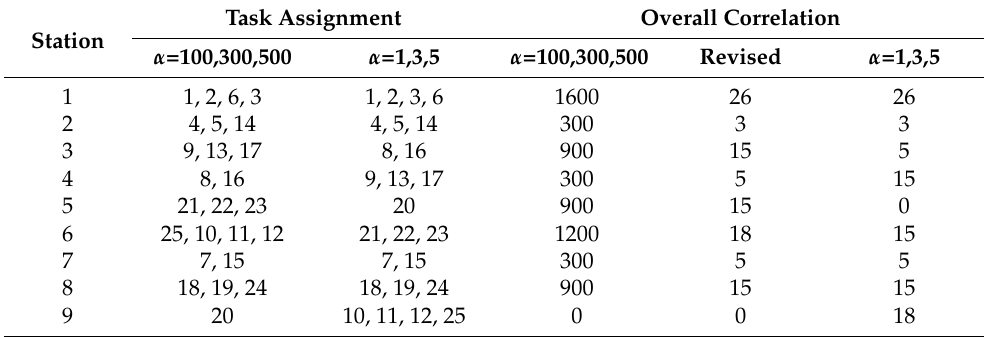
Table 6. Sensitivity analysis considering α = 100,300,500 and α = 1,3,5.